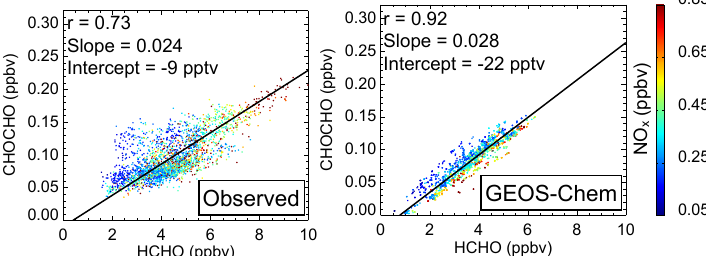
Figure 5. Relationship between CHOCHO and HCHO concentrations in the mixed layer ( < 1kma.g.l.) during SENEX (1 June– 10 July 2013), color coded by NO x concentration. Observed concentrations (Min et al., 2016; Cazorla et al., 2015) are compared to GEOS- Chem model values sampled along the flight tracks. Lines and reported slopes are from reduced major axis regressions.